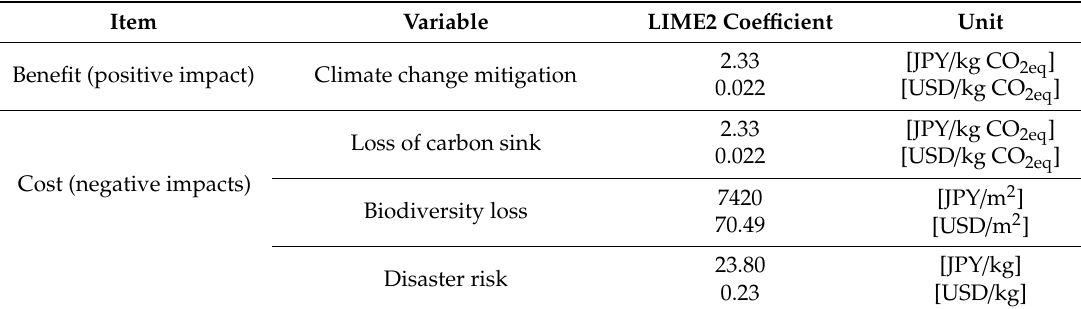
Table 3. LIME2 coe ffi